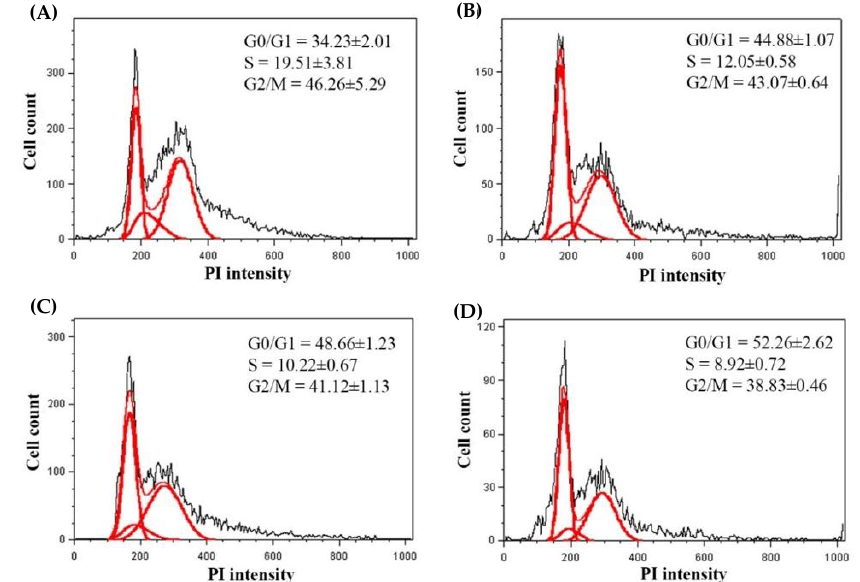
Figure 4. E ff ects of CTE on cell cycle of 3T3-L1 cells at day 1. Histograms are shown as the control group ( A ), CTE 250 µ g / mL ( B ), 500 µ g / mL ( C ), 750 µ g / mL ( D ). Each value represents the mean ± SEM ( n = 3).